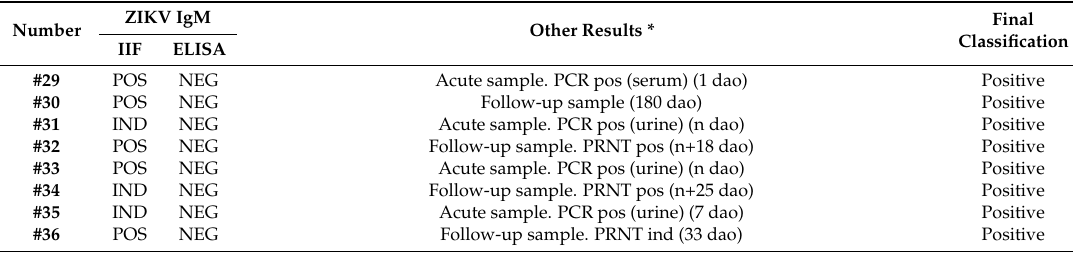
Table 3. Discrepant results finally classified as